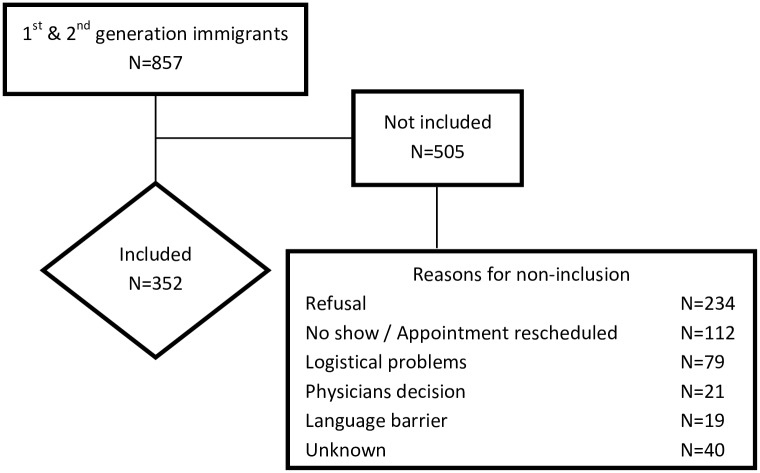
Flow diagram of patient inclusion.Legend. N = number of immigrant people living with HIV (PLWH).